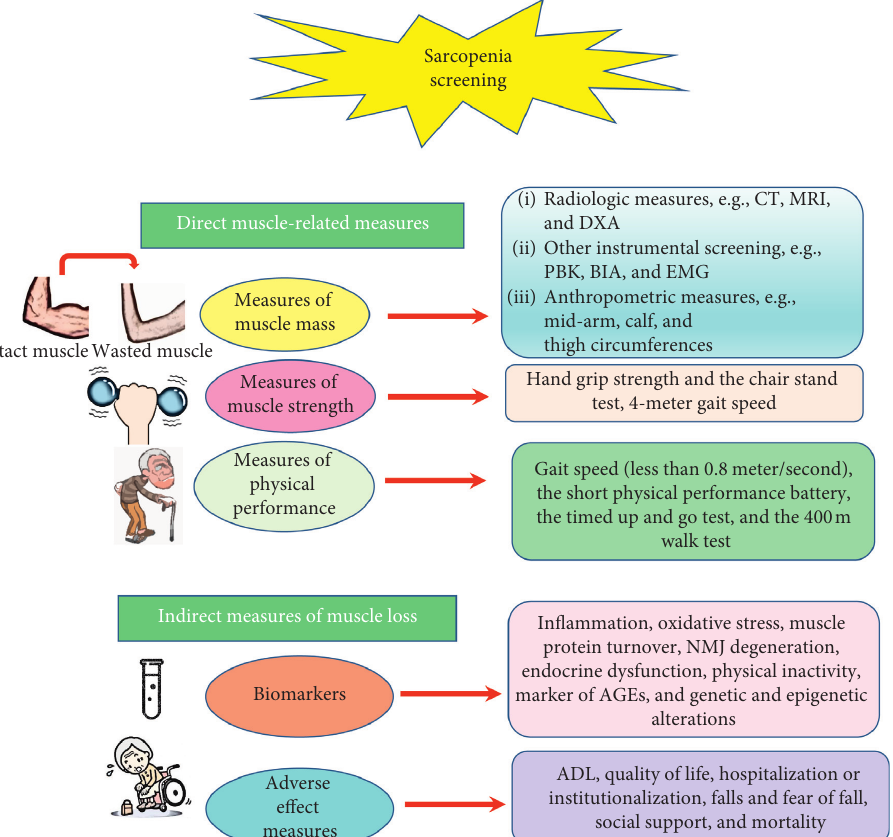
Figure 1: Schematic illustration of the algorithm used for sarcopenia screening. Abbreviations: CT: computed tomography, MRI: magnetic resonance imaging, DXA: dual-energy X-ray absorptiometry, PBK: partial body potassium, BIA: bioelectrical impedance analysis, EMG: electromyography, and NMJ: neuromuscular junction. The most commonly used algorithm for the diagnosis of sarcopenia involves